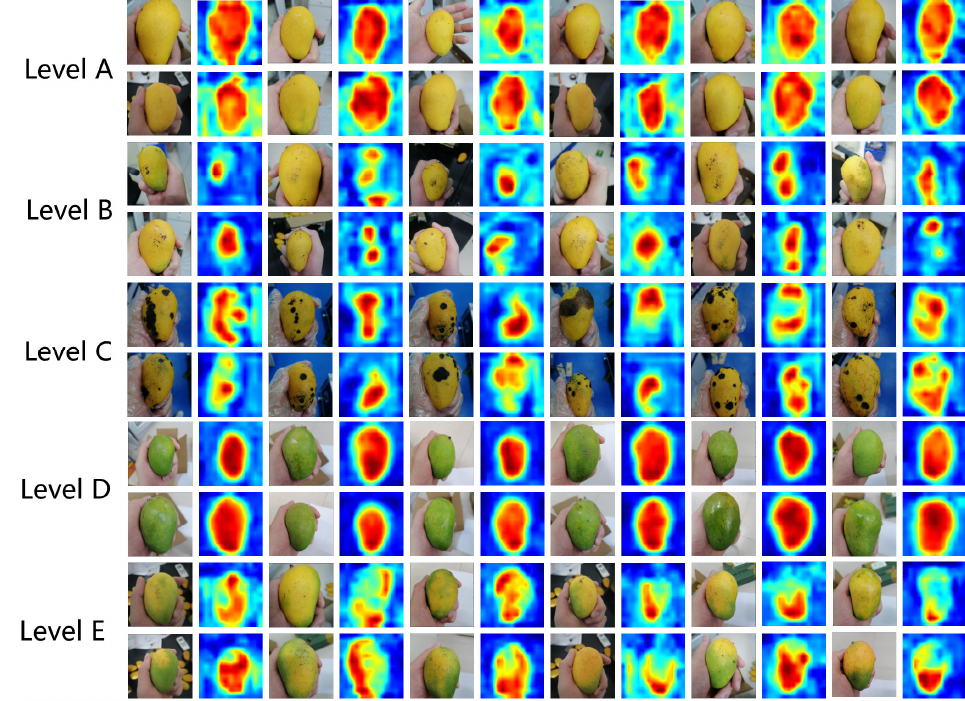
Figure 12. CAM of different levels of mango.